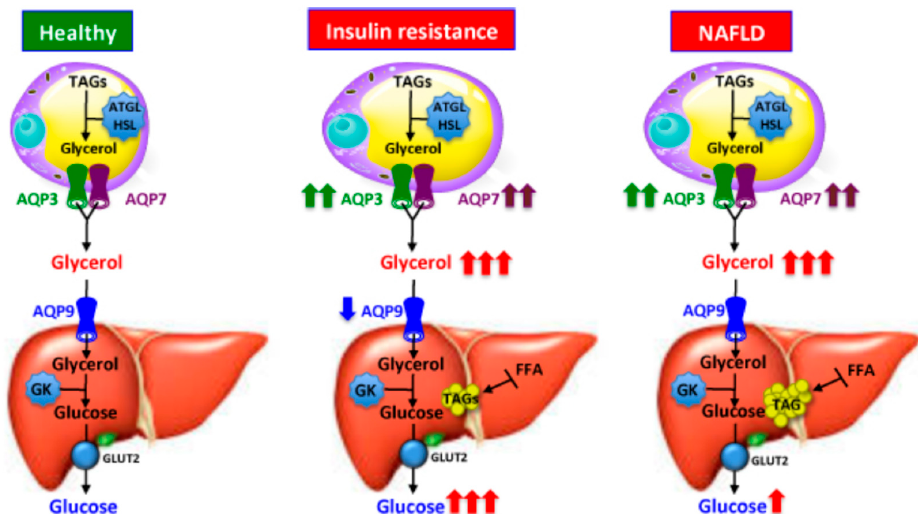
Figure 3. Working model for the function of aquaglyceroporins in the onset of insulin resistance and Non-Alcoholic Fatty Liver Disease (NAFLD) in humans. Insulin and leptin are regulatory factors for the expression of adipocyte AQP3 and AQP7 and hepatocyte AQP9. Circulating insulin and leptin levels vary in accordance to the metabolic state and adiposity, respectively. Hence, the expression of aquaglyceroporins in fat tissue and hepatocytes augments or diminishes in function of the nutritional needs and excess adipose mass. In the setting of obesity-associated insulin resistance and NAFLD, despite the hyperleptinemia, adipocyte AQP3 and AQP7 undergo overexpression. This leads to the increase of glycerol output from fat cells and glycerol use for hepatic gluconeogenesis and lipid synthesis. The reduced levels of AQP9 and glycerol permeability in the liver of obese subjects with insulin resistance is speculated to be a counteracting mechanism to prevent a further aggravation in liver steatosis and hyperglycemia. ATGL, adipose tissue triacylglycerol lipase; GLUT2, Gcose transporter, type 2; HSL, hormone-sensitive lipase; FFA, free fatty acids; GK, glycerol kinase; TAGs, triacylglycerols.